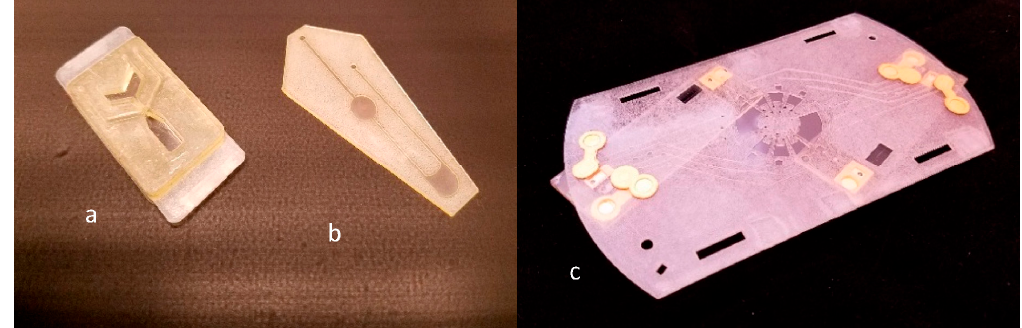
Figure 3. ( a ) DNA extraction [7]; ( b ) PCR device [8]; ( c ) Separation device [9]. Note, DNA extraction